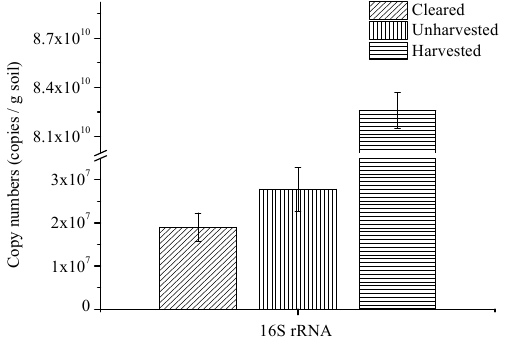
Figure 2. Copy numbers for 16S rRNA of total bacterial in soil samples. Error bars represent the standard error ( n = 3).